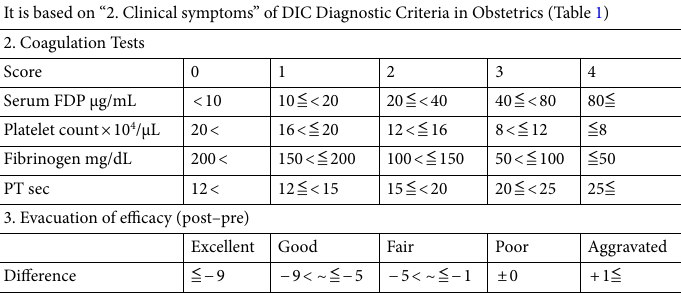
Table 5. Efficacy evaluation criteria for DIC in obstetrics. DIC, disseminated intravascular coagulation; FDP, fibrinogen and fibrin degradation; PT, prothrombin